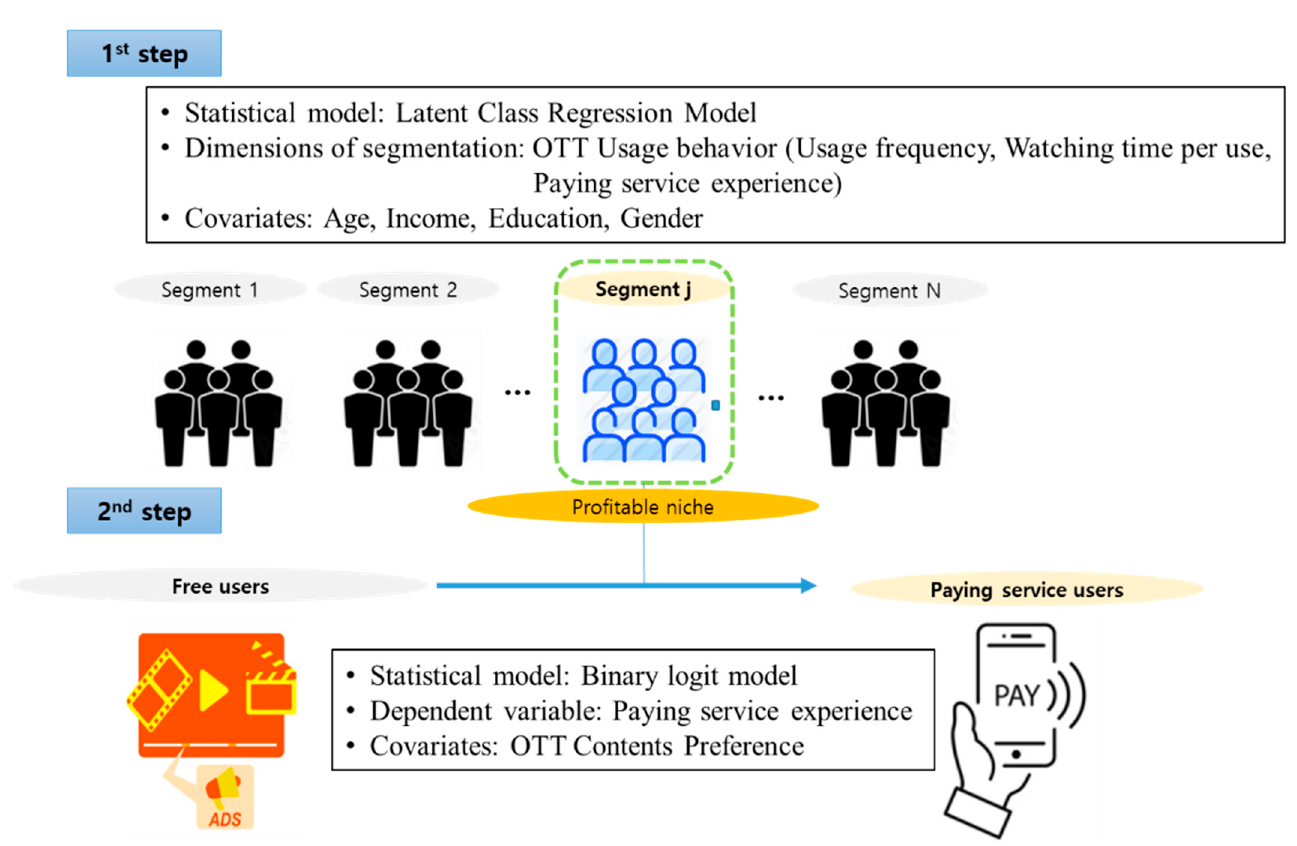
Figure 1. Research Framework.